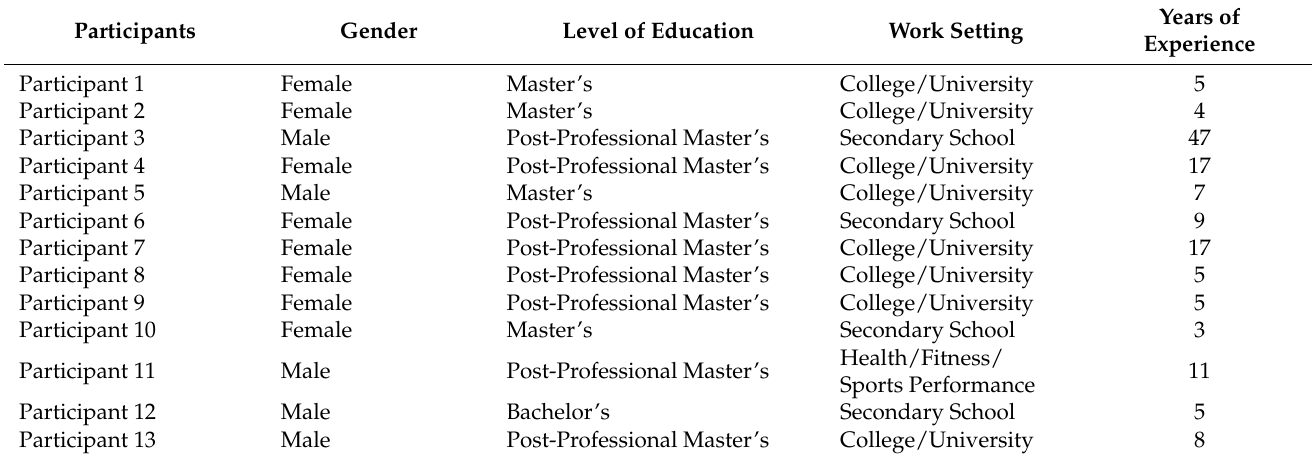
Table 1. Participant demographic ( n =